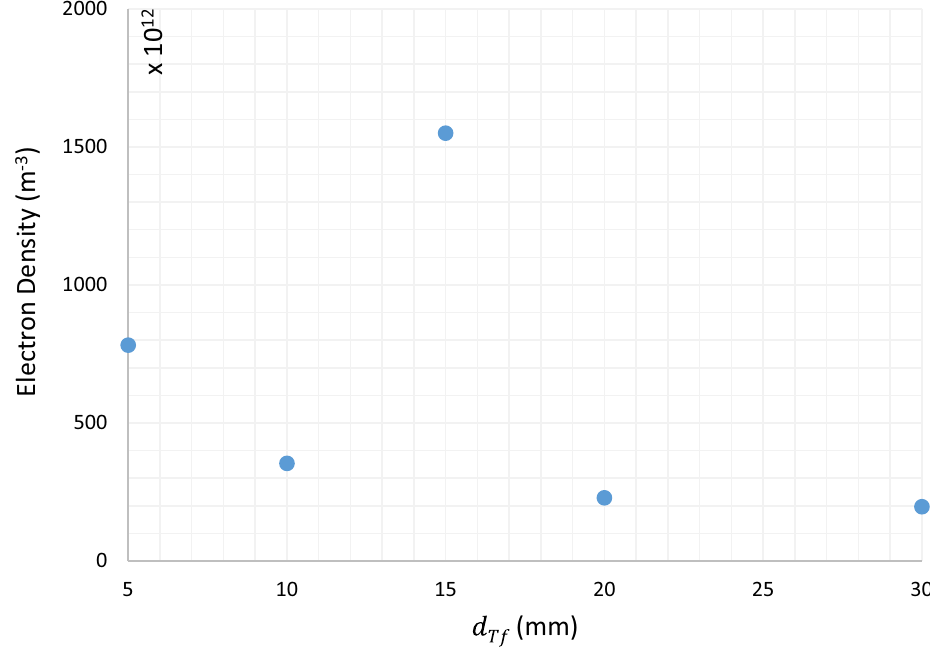
Figure 5. Mean electron density at t = 150 ns .